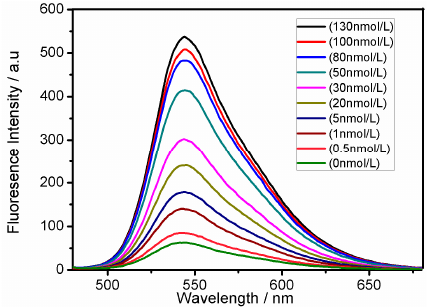
Figure 5. Changing of fluorescence emission spectra of thefunctionalized Pdots-BHQ-TBA system upon titration by thrombin: 0, 0.5,1, 5, 20, 30, 50, 80, 100, and 130 nM in HEPES buffer (20 mM, pH 7.4).Excitation was performed at 455 nm.